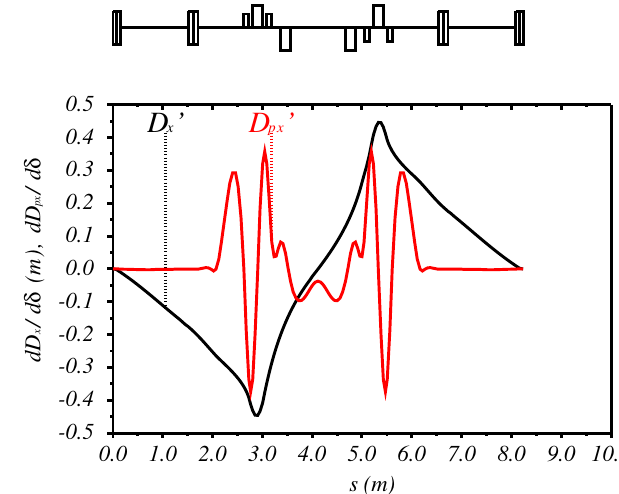
FIG. 2. First order optics of bunch compressor one. Black curve denotes horizontal beta function, red curve vertical beta function, blue curve horizontal dispersion function, and green curve horizontal angular dispersion function.